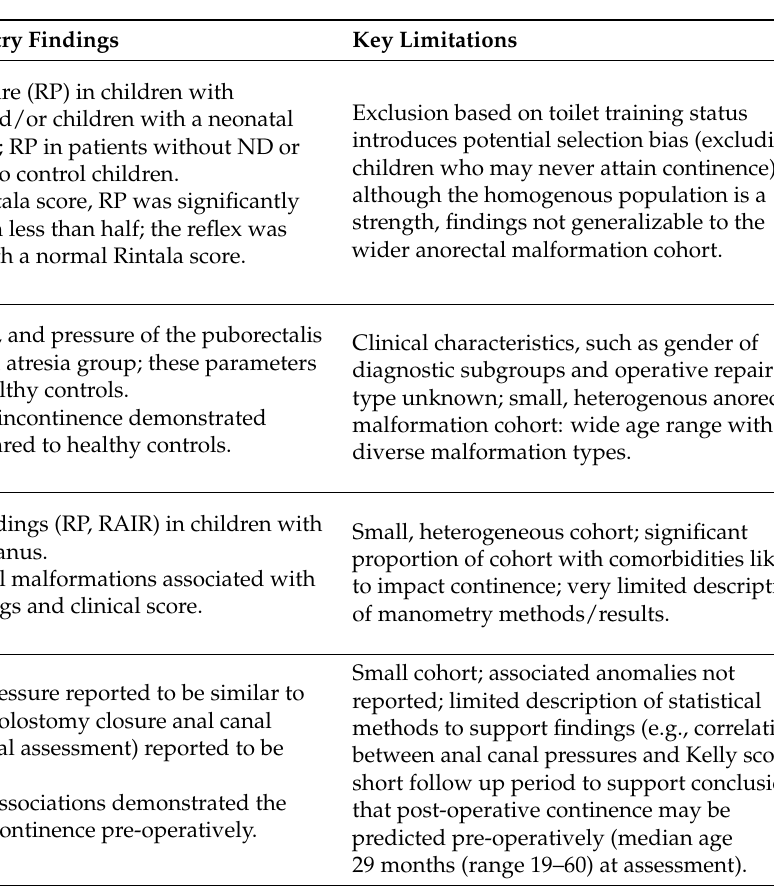
Table 4. Summary of key anorectal manometry